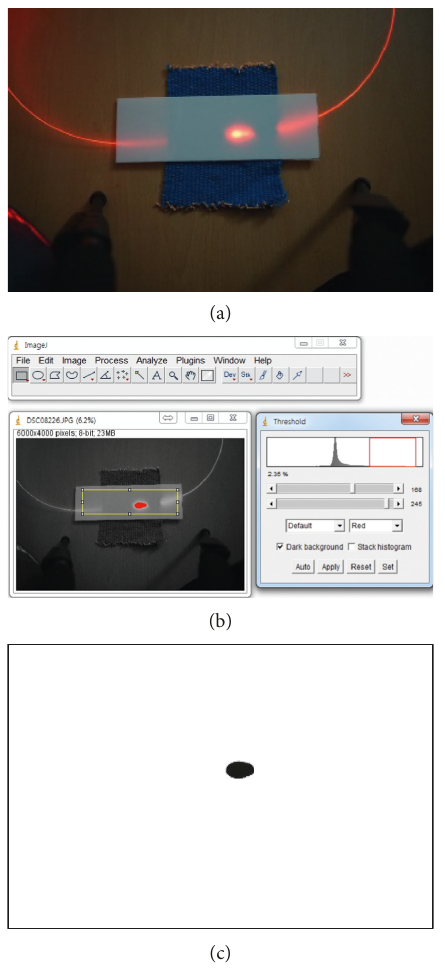
Figure 2: Measurement of total light scattered area using image analysis tool. (a) Example of an original image. (b) Image processing using ImageJ software. (c) Resultant thresholded image.